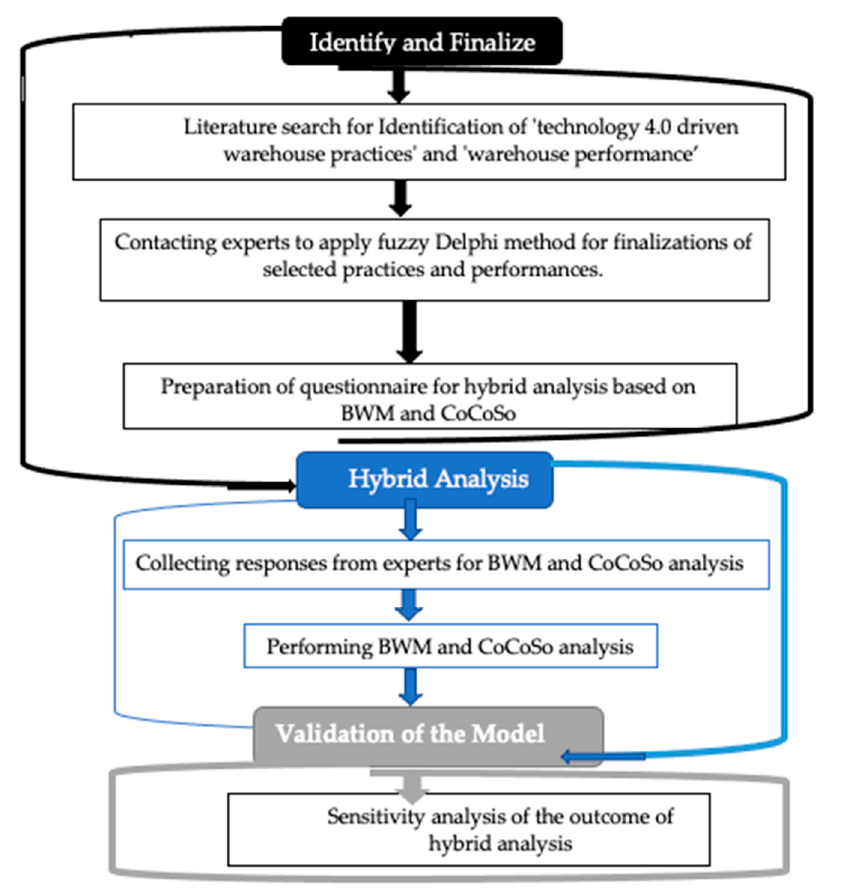
Figure 1. Steps of decision-making framework.